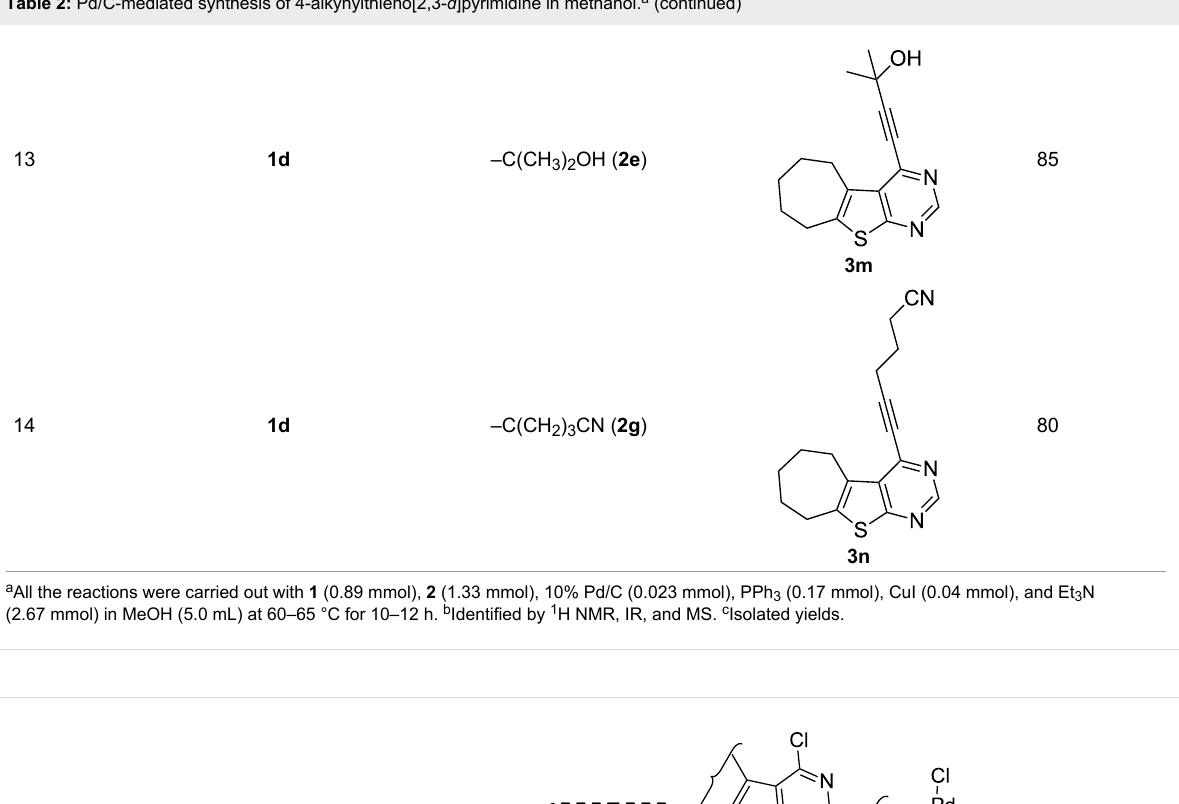
Table 2: Pd/C-mediated synthesis of 4-alkynylthieno[2,3- d ]pyrimidine in methanol. a